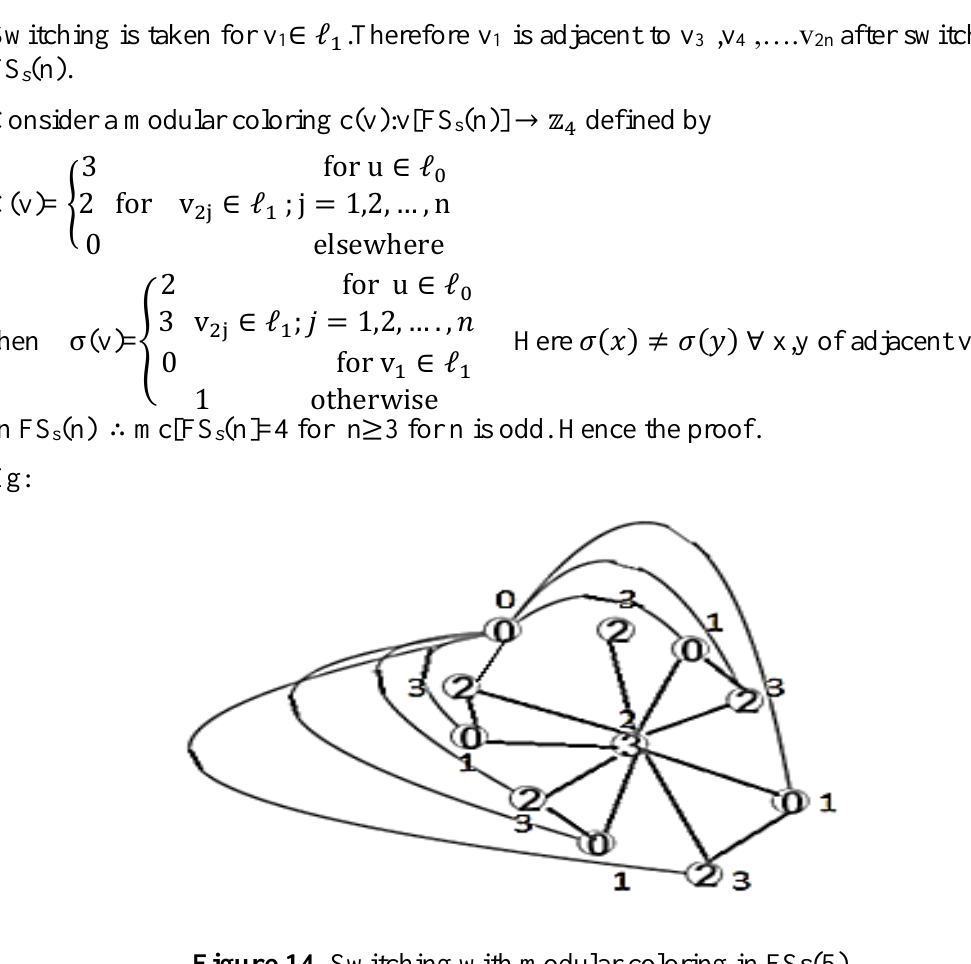
Figure 14 . Switching with modular coloring in